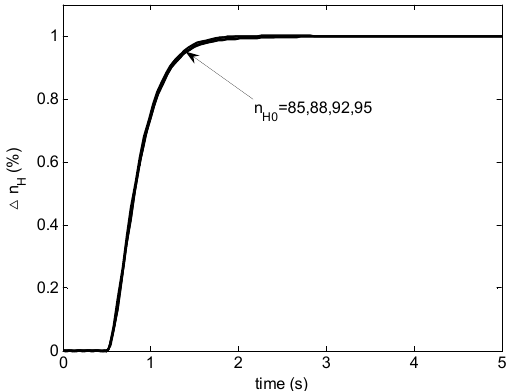
Figure 9. Modified PI gain scheduled controller.